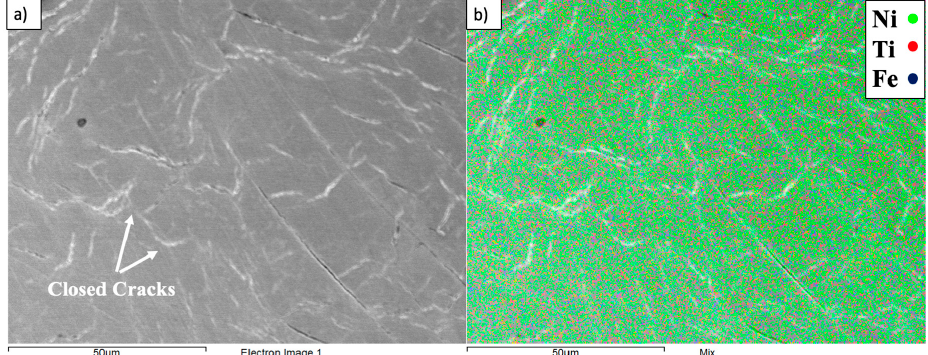
Figure 7. Impact site of 650 ◦ C nanolaminate ( a ) scanning electron microscopy (SEM) and ( b ) EDS map of 90 ◦ impact.